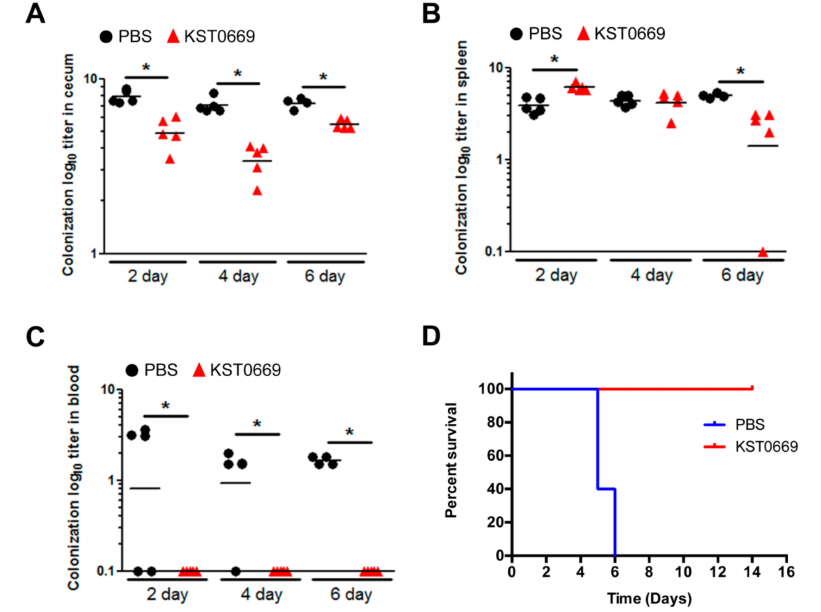
Figure 7. Protection against Salmonella infections. Mice ( n = 5 per group) were orally immunized with PBS (black circle) or KST0669 (red triangle) twice at two-week intervals and then infected orally with 1 × 10 6 CFU Salmonella Typhimurium LT2 strain. ( A – C ) Mice organs (cecum and spleen) and bloods were isolated at 2, 4, or 6 days post-infection. The CFU of bacteria in the cecum ( A ), the spleen ( B ), and blood ( C ) were counted. ( D ) Mice survival was monitored for 14 days. Data are expressed as mean ± SEM per group and analyzed by unpaired t test. * p <